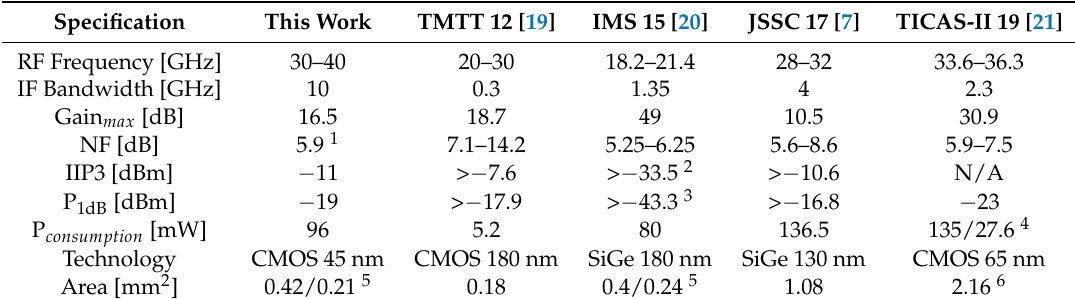
Table 2. Performance